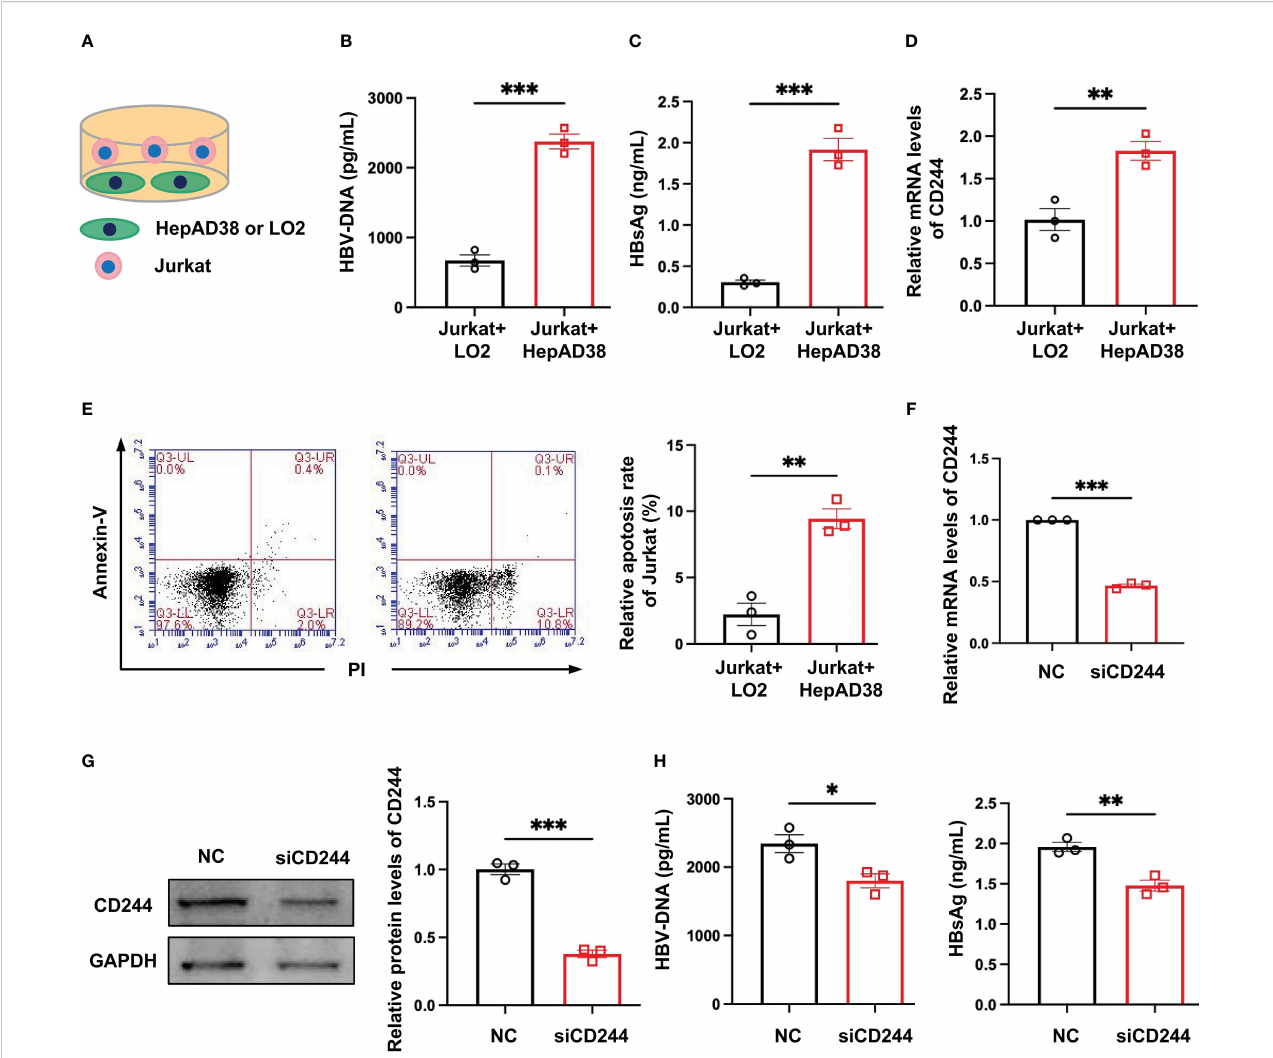
FIGURE 3 CD244 expression regulated T cells apoptosis with or without infection of HBV. (A) The co-culture scheme of LO2 hepatocytes or HBV infected HepAD38 cells with Jurkat cells. (B) HBV DNA detection in co-culture cells using ELISA. (C) HBsAg detection in co-culture cells using ELISA. (D) RT-PCR analysis of CD244 expression in Jurkat cells. (E) The apoptosis of Jurkat cells were identi fi ed by Annexin V/PI staining. (F, G) The expression of CD244 mRNA levels (F) and protein levels (G) in Jurkat cells after siCD244 transfection of co-cultured system. (H) Quanti fi cation of HBV DNA and HBsAg by ELISA kit. Data (n = 3 per group) were expressed as mean ± SEM and analyzed using Student t test, * P < 0.05, ** P < 0.01, *** P <